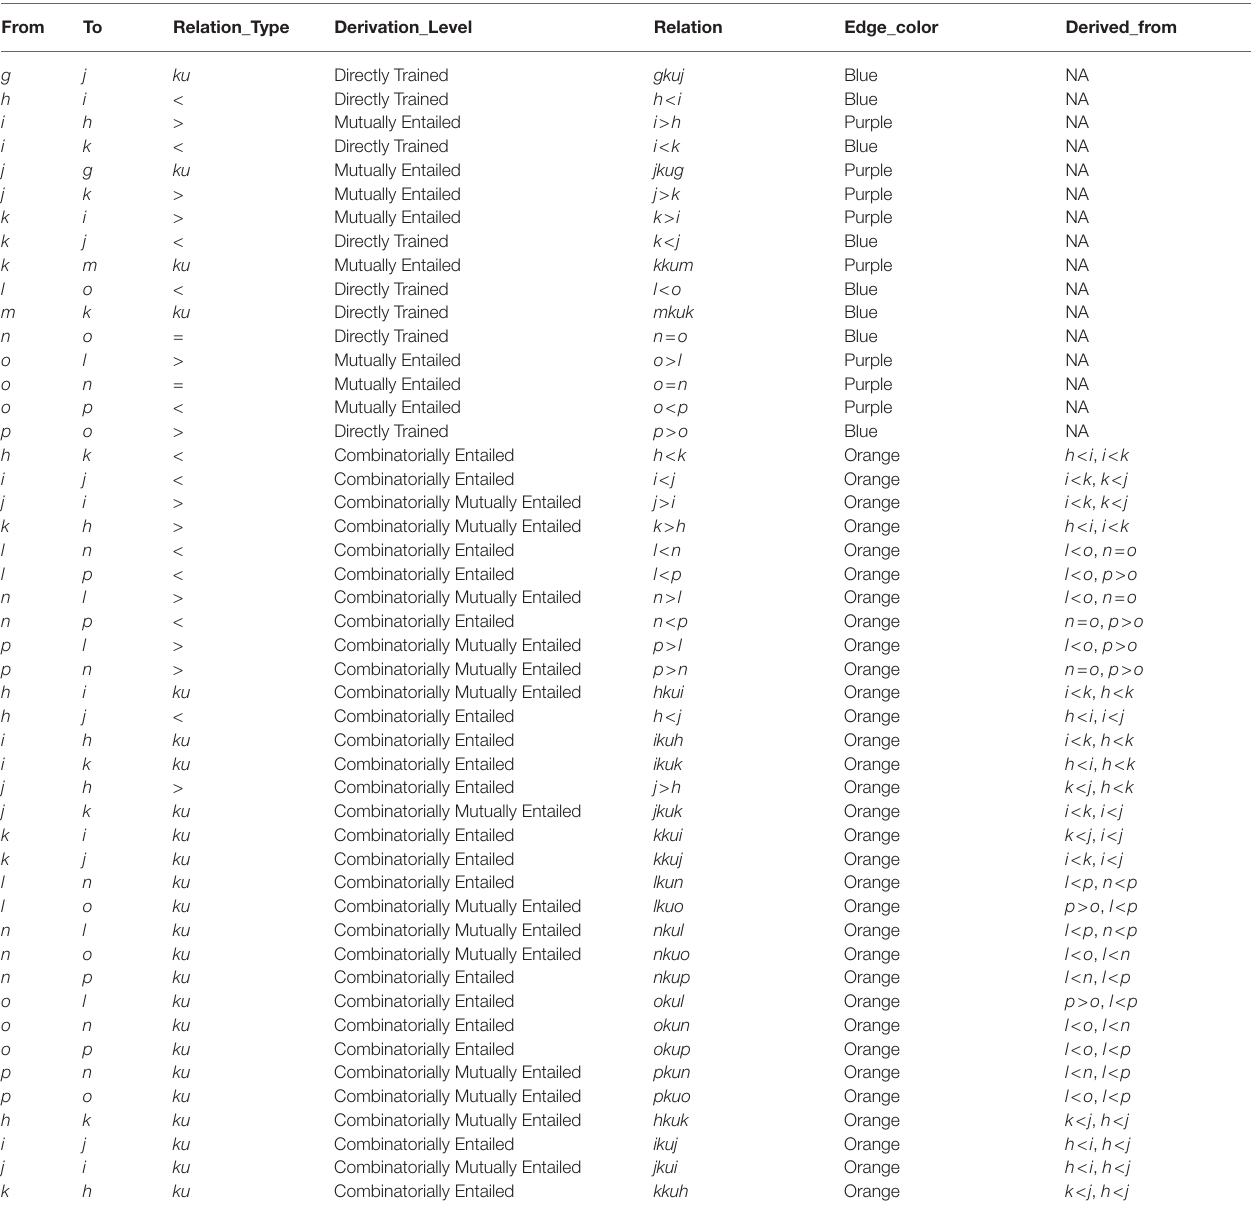
TABLE 3 | RelationTrain output for complex mixed relation